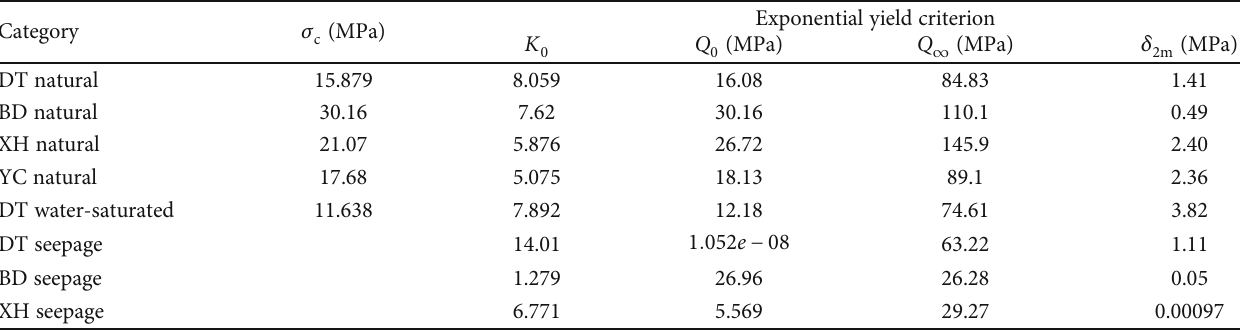
Table 3: Fitted results of exponential yield